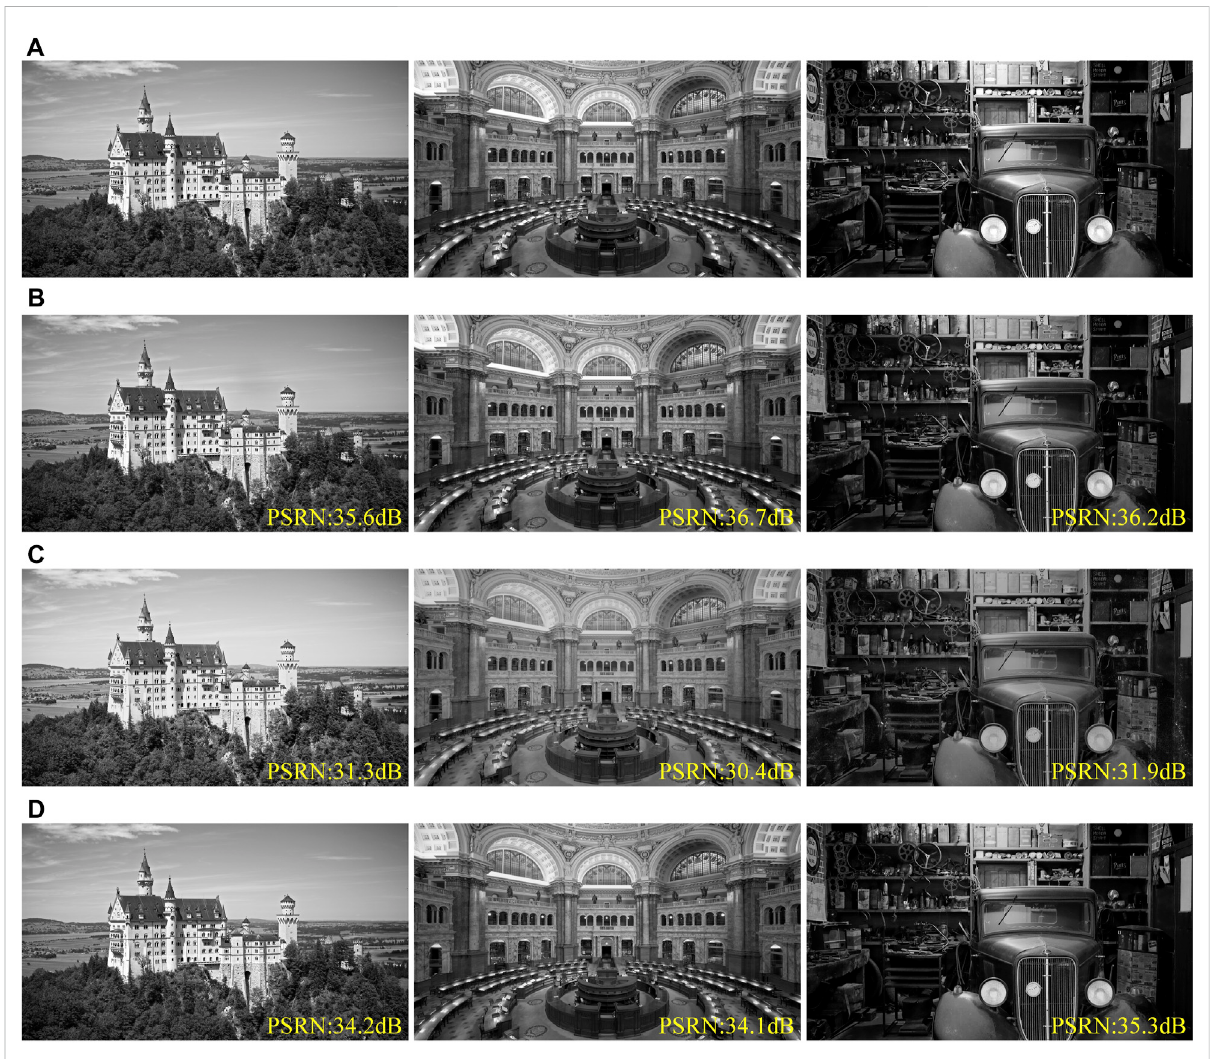
FIGURE 10 Numerical reconstructed images of phase-only holograms generated by different methods. (A) Target images, (B) WH, (C) DPH, and (D) the proposed